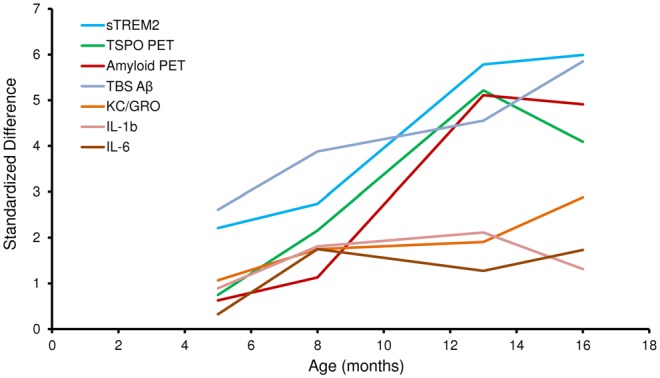
Standardized differences for biochemical and imaging modalities during the life course of PS2APP mice. Data information: standardized differences between PS2APP and WT mice were computed by the delta divided by the standard deviation for all assessment points in PS2APP. The development of measures in WT was assumed linear when no direct comparison time-point was available.